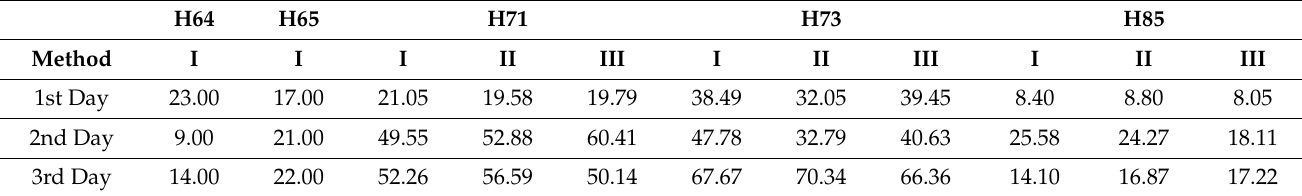
Table 8. Statistical analysis of the forecasting SDE values of the